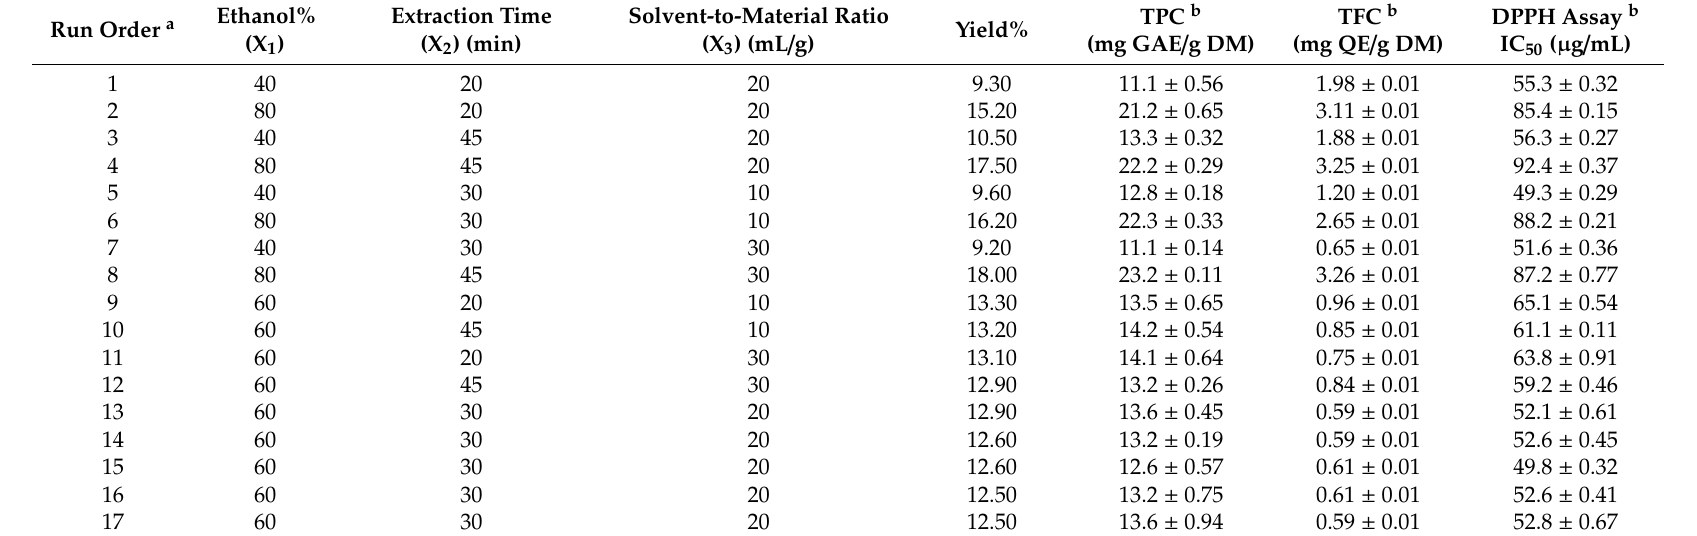
Table 1. Box–Behnken Design (BBD) experimental design with the independent variables and observed